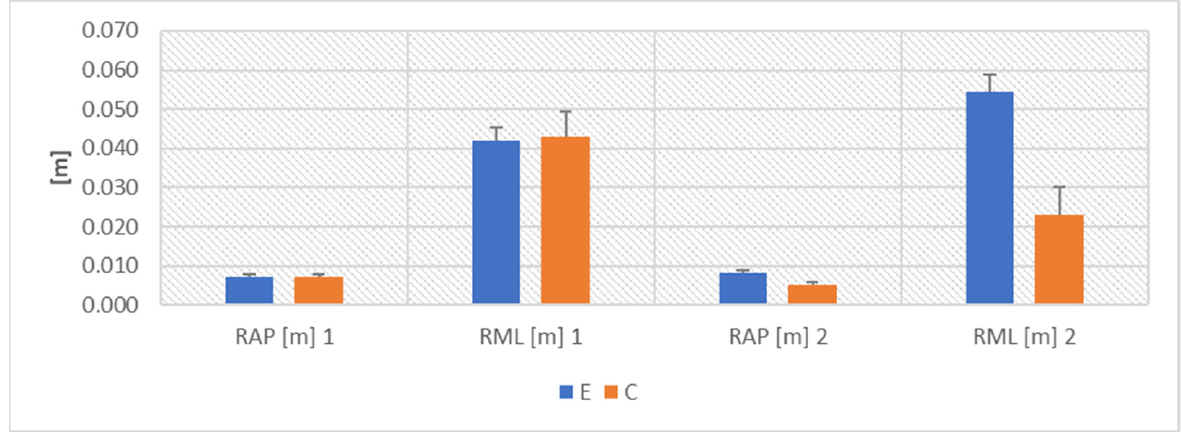
Figure 1. Mean values ± SD of COM displacement.